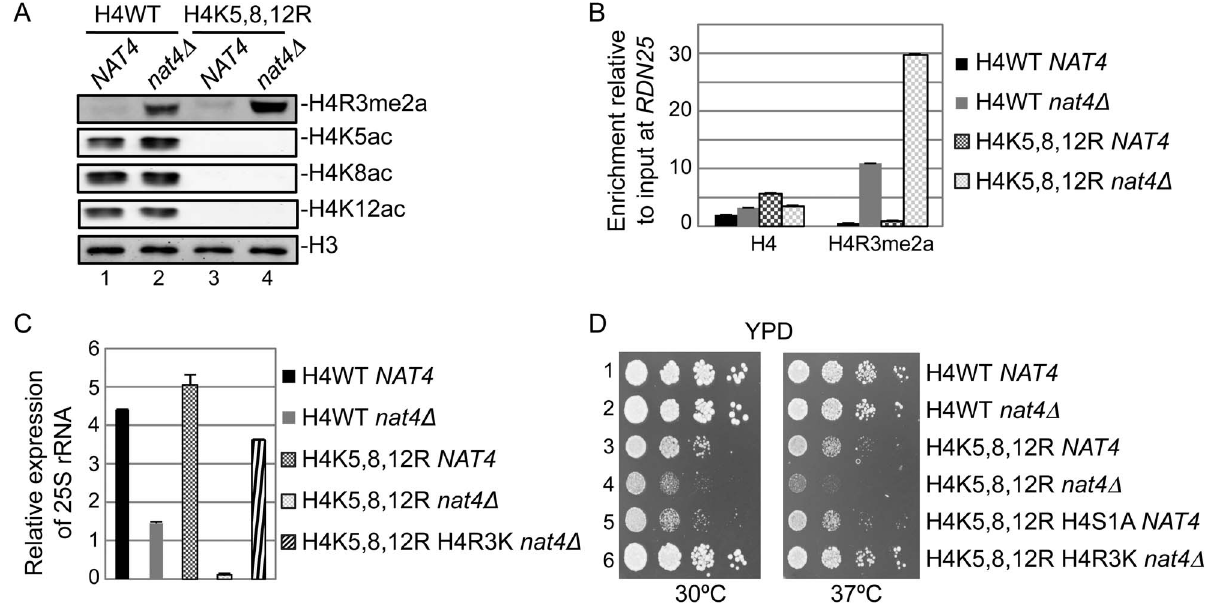
Figure 5. N-acH4 acts synergistically with H4K5, 8, 12 acetylation to control rDNA silencing, H4R3me2a and cell growth. (A) Whole yeast cell extracts were prepared from the wild-type (H4WT NAT4 ) and the mutant strains carrying a NAT4 deletion (H4WT nat4 D ), a triple Lysine-to- Arginine mutation in H4 in positions 5, 8 and 12 (H4K5,8,12R NAT4 ) or both (H4K5,8,12R nat4 D ) and then analyzed by western blotting using the H4 modification antibodies are shown. Equal loading was monitored with an H3 antibody (bottom panel). (B) ChIP experiments were performed in the same strains as in ( A ) using the antibodies against H4 and H4R3me2a. The enrichment of each antibody was analyzed as in (3B) . (C) 25S rRNA expression level analysis was performed in the wild-type (H4WT NAT4 ) and the mutant strains carrying a NAT4 deletion (H4WT nat4 D ), a triple H4 Lysine-to-Arginine mutation in positions 5, 8 and 12 (H4K5,8,12R NAT4 ) both (H4K5,8,12R nat4 D ), and a multiple H4 mutant with a triple Lysine-to- Arginine substitution in positions 5, 8 and 12, an Arginine-to-Lysine mutation in position 3, and a NAT4 deletion ( H4 K 5,8,12R H4R3K nat4 D ). The analysis was performed as in ( 3C ). Error bars in (B) and (C) indicate s.e.m for duplicate experiments. (D) Growth assay of the same yeast strains as in (C) plus a multiple H4 mutant with a triple Lysine-to-Arginine substitution in positions 5, 8 and 12, and Serine-to-Alanine mutation in position 1 (H4K5,8,12R H4S1A NAT4 ). Cells were spotted in 10-fold dilutions on YPAD medium plates. Cell growth was examined at 30 u C (left panel) or 37 u C (right